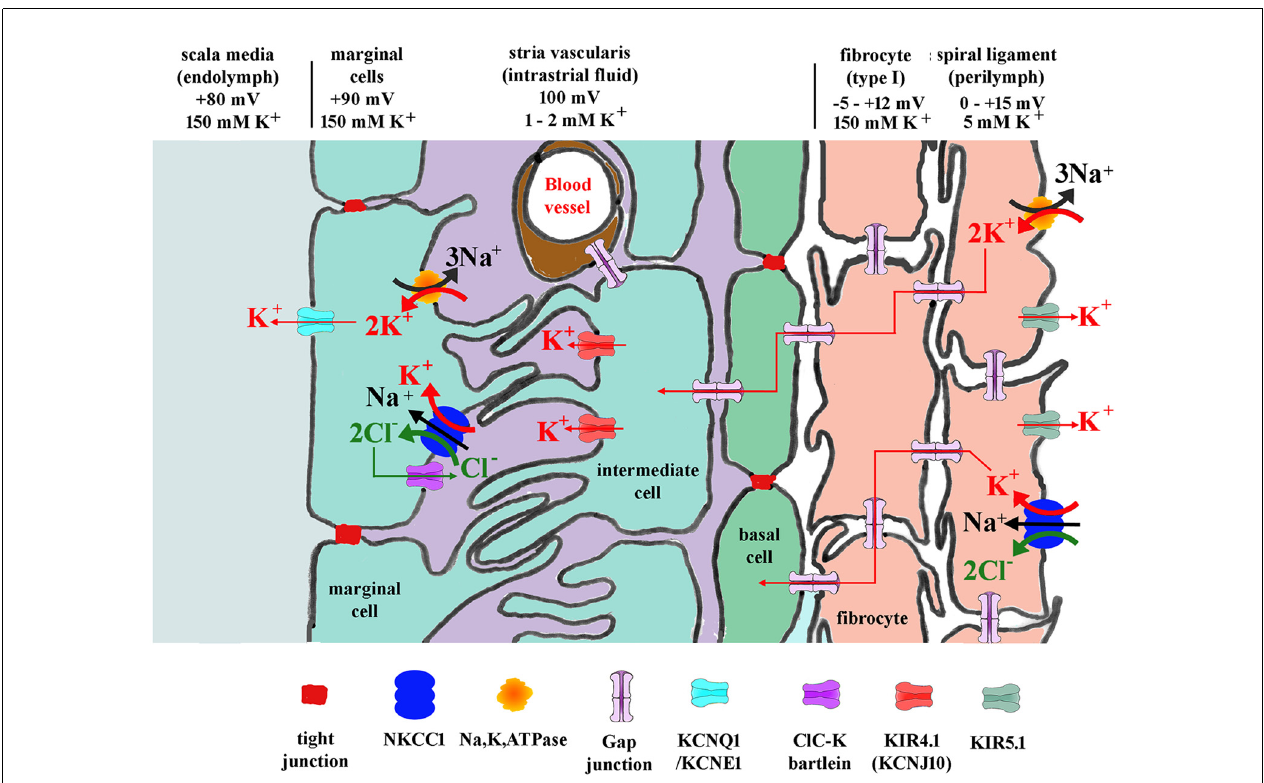
FIGURE 3 | Diagram showing potassium and other ion circulation and the formation of the EP within the lateral wall. In the stria vascularis and the spiral ligament, K + concentration gradients ([K + ]) and potentials vary at different points in the tissue as shown. Gap junctions connect the spiral ligament fibrocytes together and also connect them to basal cells and then intermediate cells of the stria vascularis. K + entering from outer sulcus cells of the organ of Corti or directly from perilymph via Na, K, ATPase or NKCC1 then flows through the syncytium of the ligament into the stria vascularis where it is transported to marginal cells and secreted into endolymph. For protein identity, see key below diagram. Modified figure based on Hibino and Kurachi (2006) with additional data from Adachi et al.